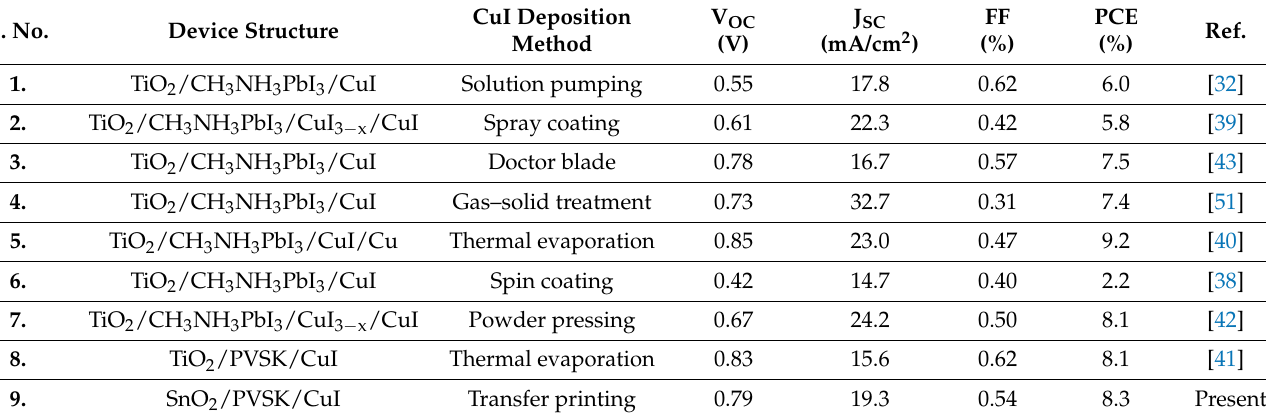
Table 3. Comparison of (n–i–p) device structures and parameters for CuI HTL-based devices.